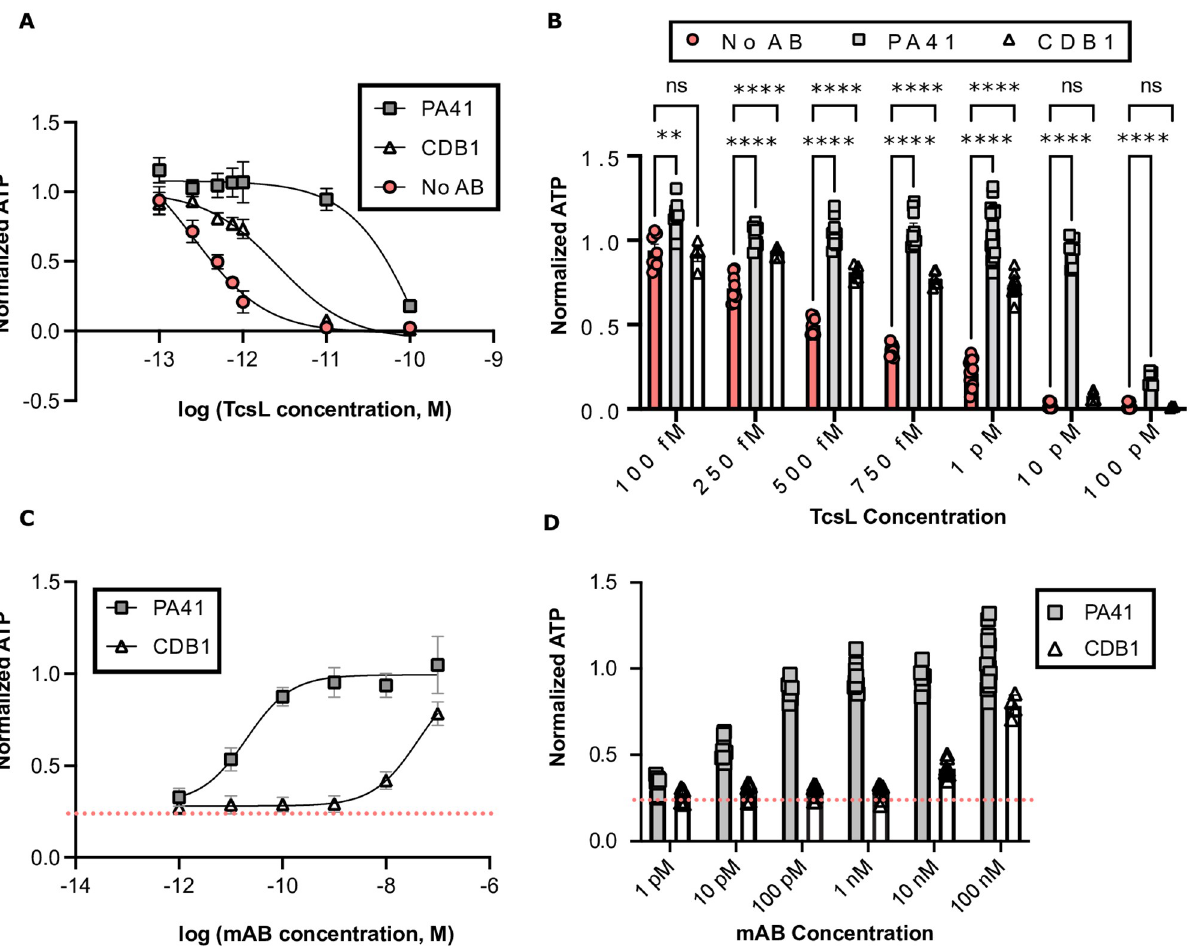
Fig 1. Neutralization of TcsL cytotoxicity by C . difficile monoclonal antibodies, PA41 and CDB1, in vitro . ( A-B ) Vero cells were treated with serial dilutions of TcsL alone or in the presence of 100 nM PA41 or CDB1. ATP was measured as a readout of viability and normalized to signal from untreated cells. Dunnett’s test for multiple comparisons was used with statistical significance set at a p value of < 0.05, where ���� represents p < 0.0001. ( C-D ) Vero cells were treated with a serial dilution of PA41 or CDB1 in the presence of 1 pM TcsL (IC 50 = 20 pM and ~41 nM, respectively). The baseline for 1 pM TcsL cytotoxicity is indicated by the dotted